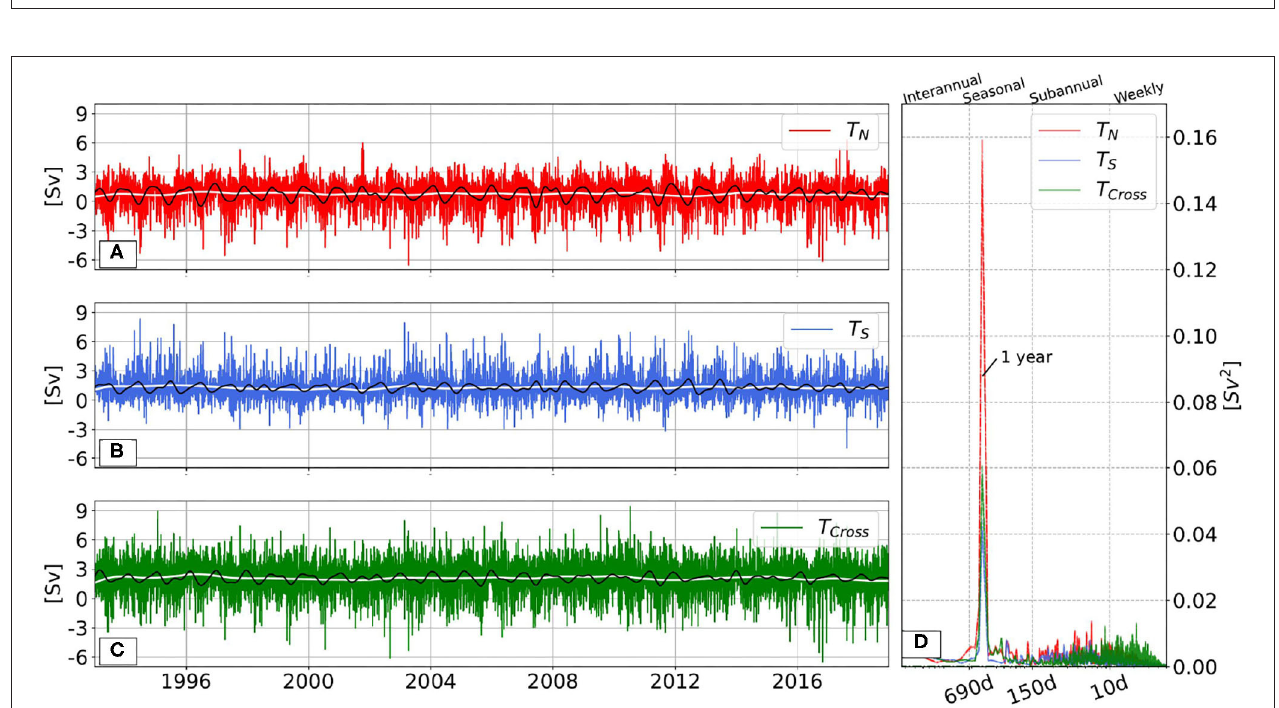
FIGURE 6 | Transports (Sv) over the continental shelf through 30 ◦ S ( A , red, T N ), 40 ◦ S ( B , blue, T S ), and cross-shore ( C , green, T Cross ). Also shown are T seasonal plus T mean (black) and T interannual plus T mean (white). (D) Transport power spectra through the same sections. Vertical lines at 10, 150, and 690 days represent the breaks between time scales.